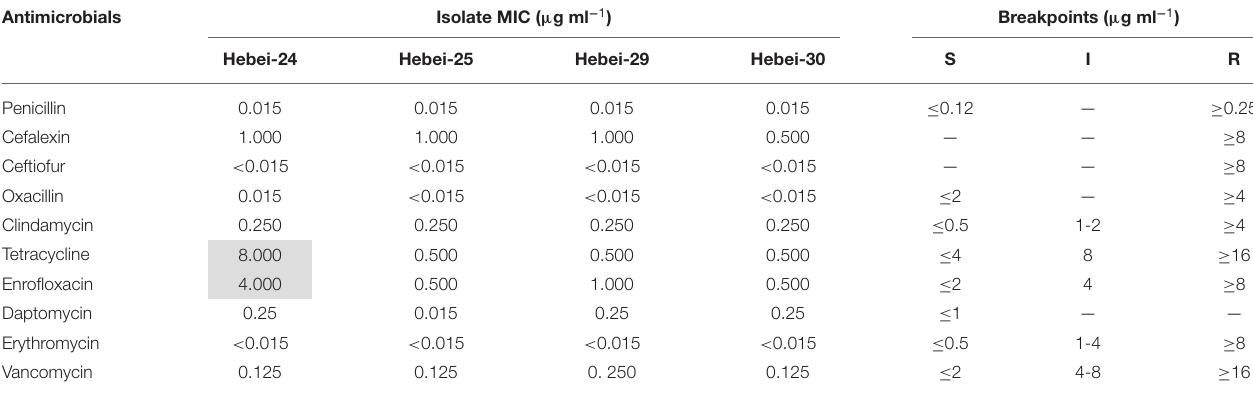
TABLE 3 | Antimicrobial resistance profiles of the four Helcococcus ovis isolates.